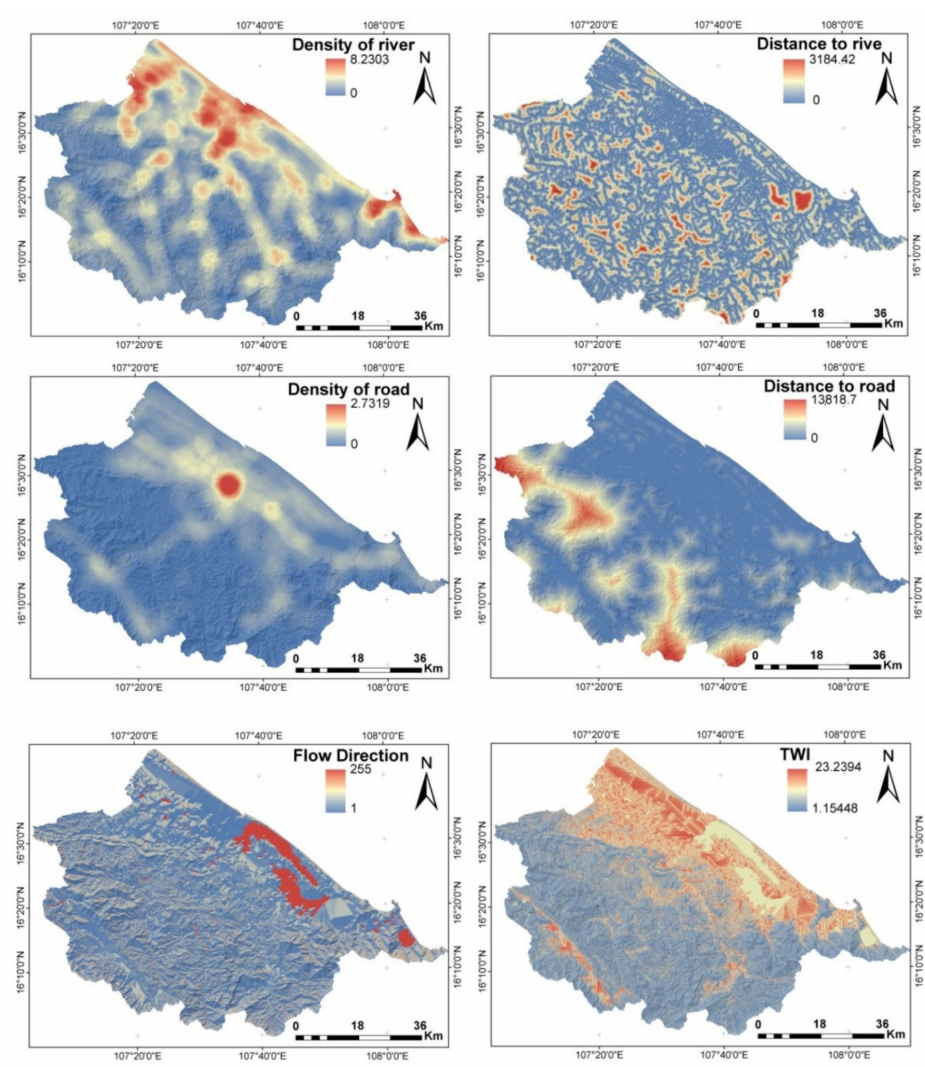
Figure 2. Variable prediction in study